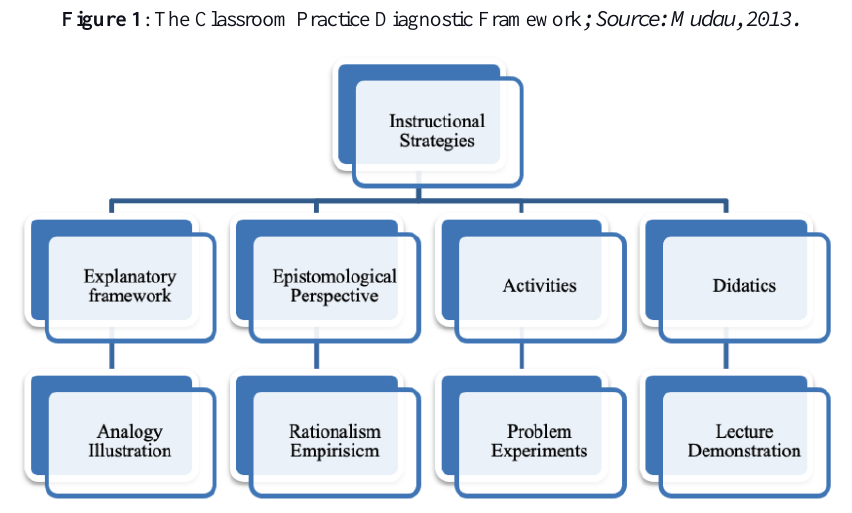
Figure 2: The Components of Instructional Strategies ; Source: Adapted from Mudau,